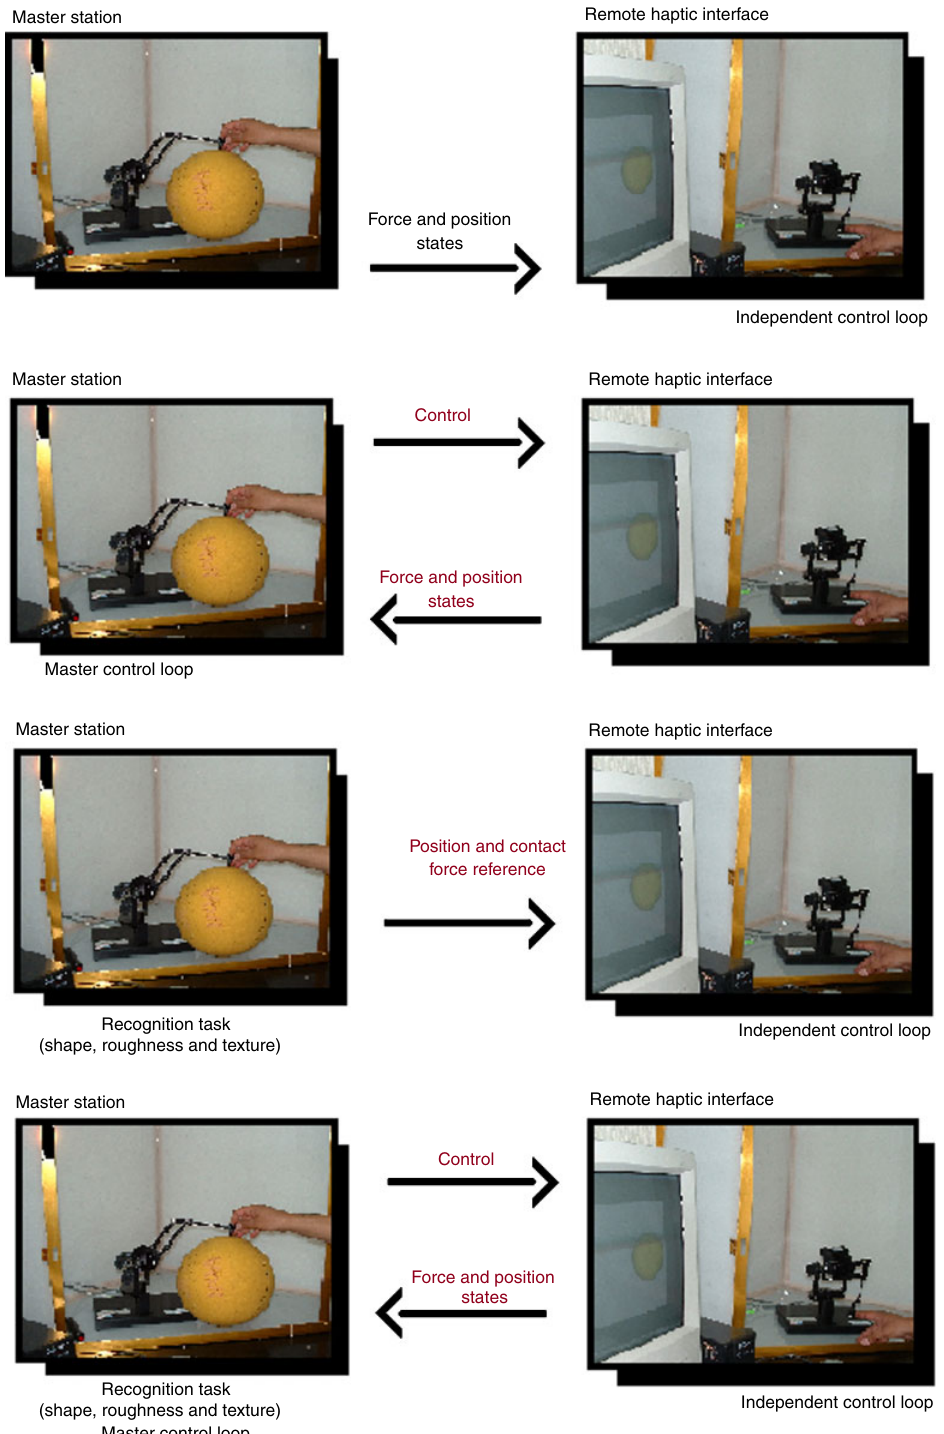
Figure 1 Four classes of haptic guidance: (1) haptic guidance; (2) haptic guidance control; (3) haptic guided exploration; and (4) haptic guided exploration